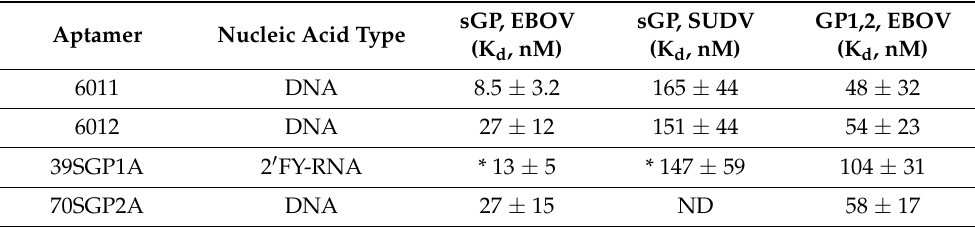
Figure 2. Binding isotherms for oligonucleotides 6011, 6012 and 39SGP1A . ( A ) Binding isotherms for 6011 with EBOV sGP, SUDV sGP, His-Lcn2 or HSA at the concentrations identified by the x- axis labels. The numbers of independently performed experiments, each assessing duplicate or triplicate samples, that contributed to these binding isotherms, were EBOV sGP (7), SUDV sGP (2), Lcn2, and HSA (1). ( B ) Binding isotherms for 6012 with EBOV sGP and SUDV sGP at the concentrations identified by the x-axis labels. The numbers of independently performed experiments, each assessing duplicate or triplicate samples, that contributed to these binding isotherms, were EBOV sGP (5) and SUDV sGP (2). ( C ) Binding isotherms of 6011 and 6012 for EBOV GP1,2 at the concentrations identified by the x-axis labels. The numbers of independently performed experiments, each assessing triplicate samples (with the exception of 6011, which was performed in duplicate), which contributed to these binding isotherms, were 6011 (3), 6012 (2), and 39SGP1A (2). In each titration, the concentrations of the proteins are for the sGP as homodimer and GP1,2 as monomer. All binding assays were performed in PBS at 24 ◦ C. Standard deviations are shown. Table 1. Binding affinities of three